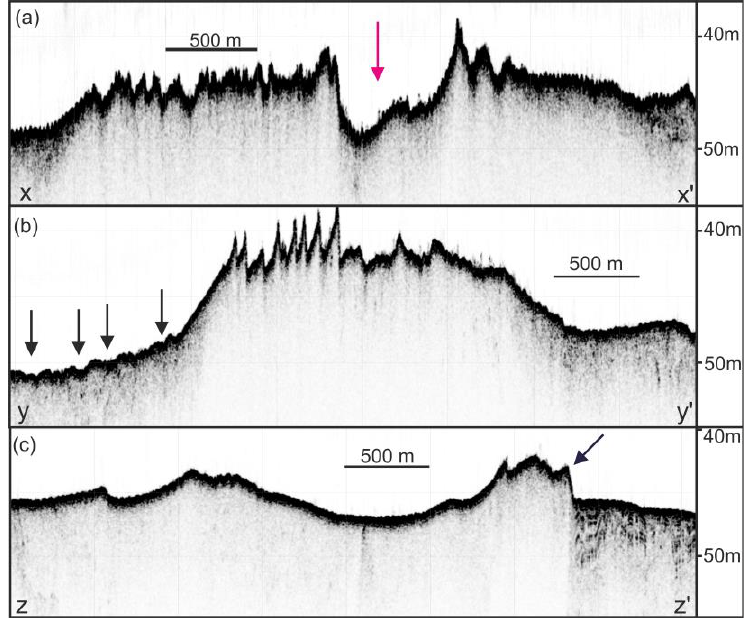
Figure 4. Sub-bottom cross-sections through the glacial landforms mapped within Area 1; see Figure 2 for locations. Arrows point to: ( a ) Ring structure; ( b ) Glacial linear features; ( c ) Terminal moraine. Glacial lineations oriented along an azimuth of 225 ◦ are identified in the bottom relief of the western part of Area 1. These lineations are not fully coherent with respect to their extent and are characterized by an incision depth of up to 0.5 m and a width of up to 50 m (black lines in Figure 2, Glacial lineations in Figure